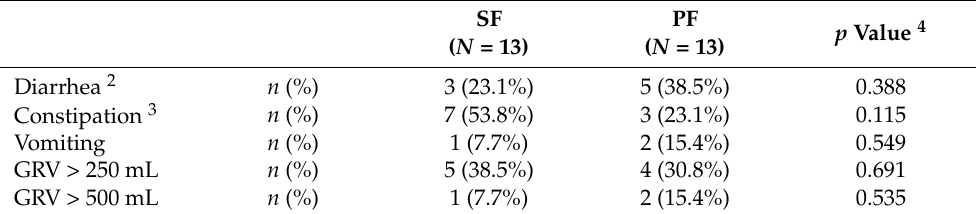
Table 3. Incidence of gastrointestinal tolerance symptoms 1 .